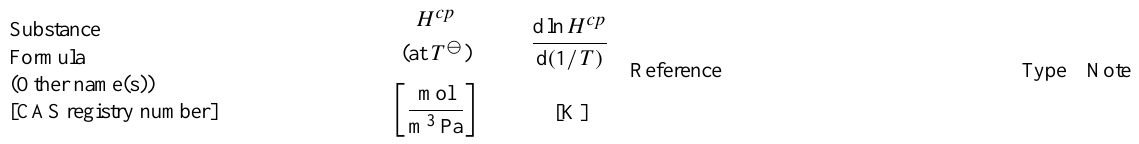
Table 6: Henry’s law constants for water as solvent